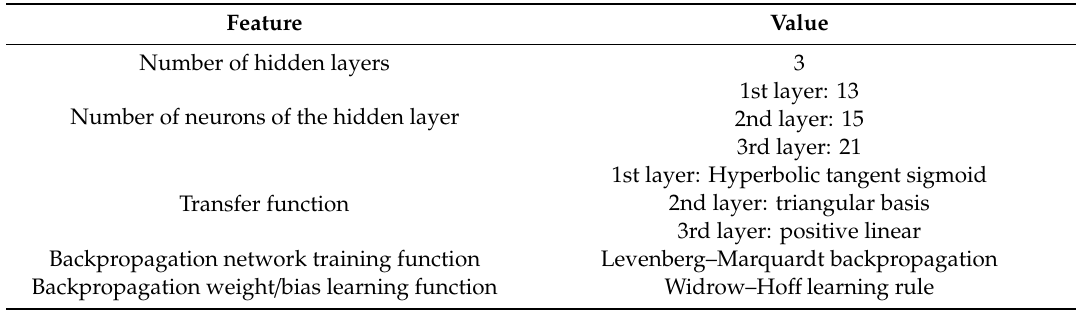
Table 3. Optimal parameters of the NN found by ANN-PSO process to classify chickpea